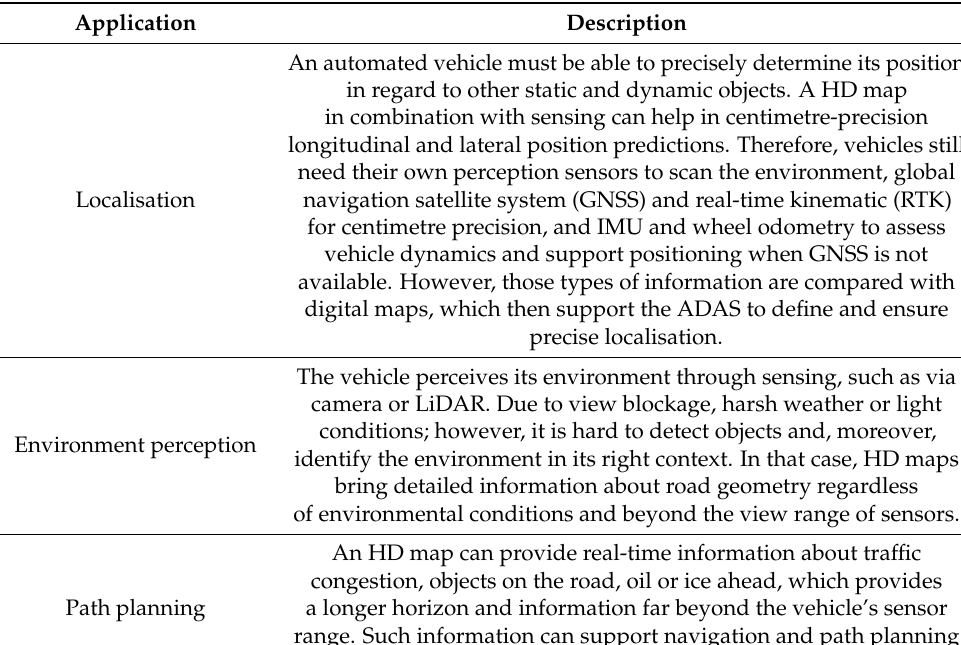
Table 4. Main fields of the digital map applications.